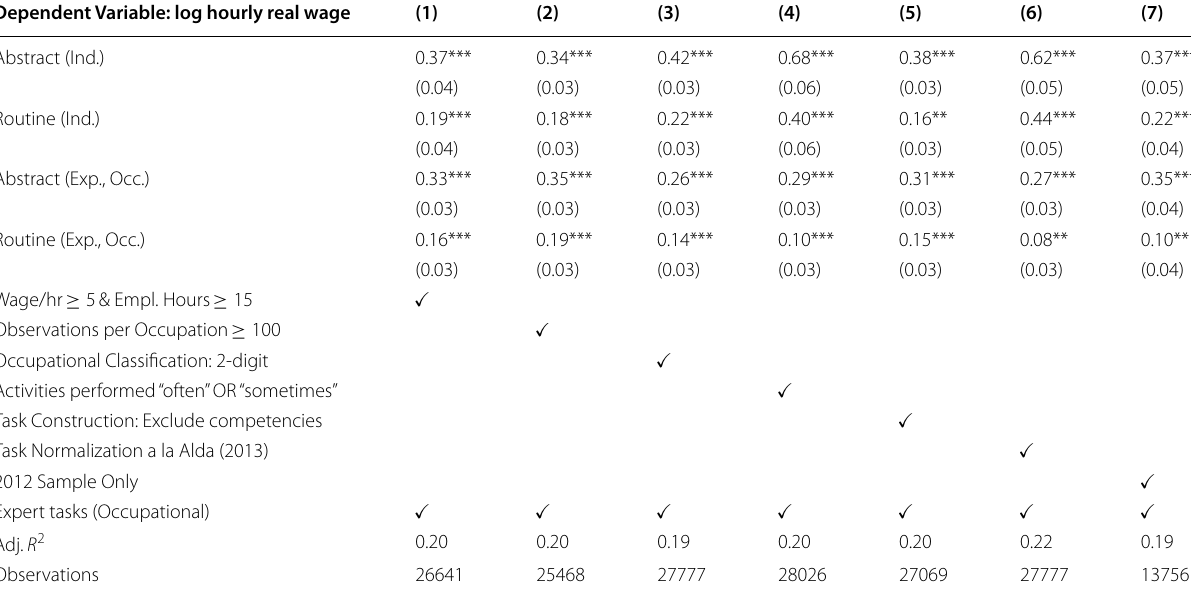
Robust standard errors in